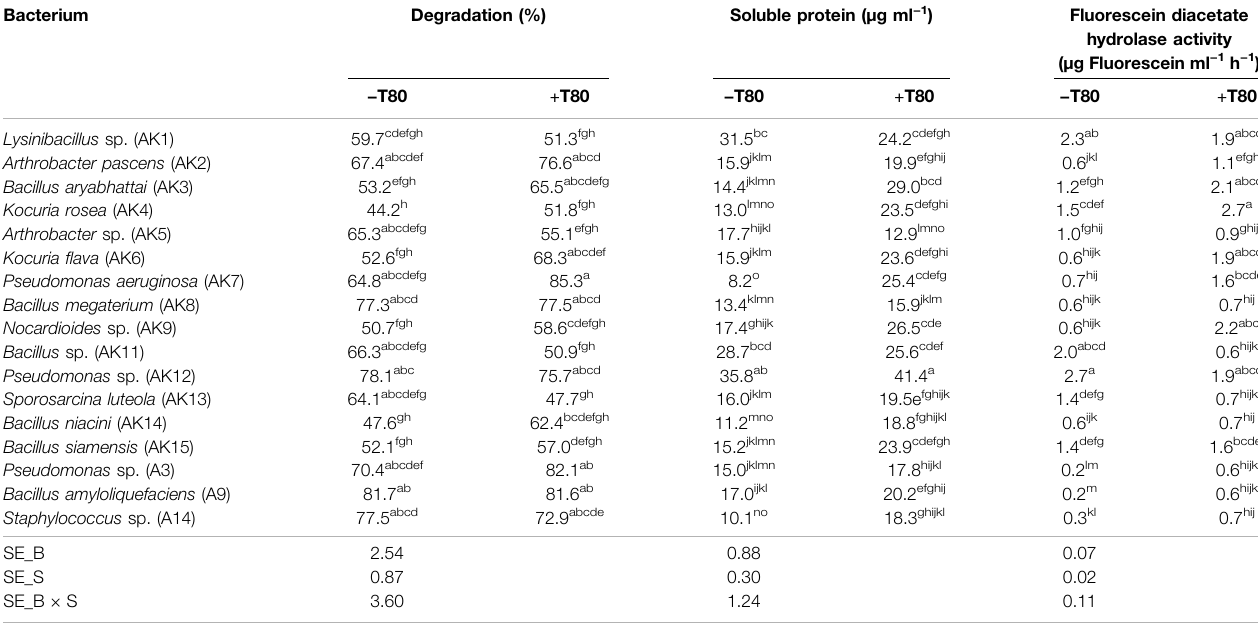
TABLE 1 | Percent degradation of aliphatic fraction of crude and enzymatic activity during crude oil degradation by different bacteria, without ( − T80) and with (+T80) Tween-80. Bacterium Degradation